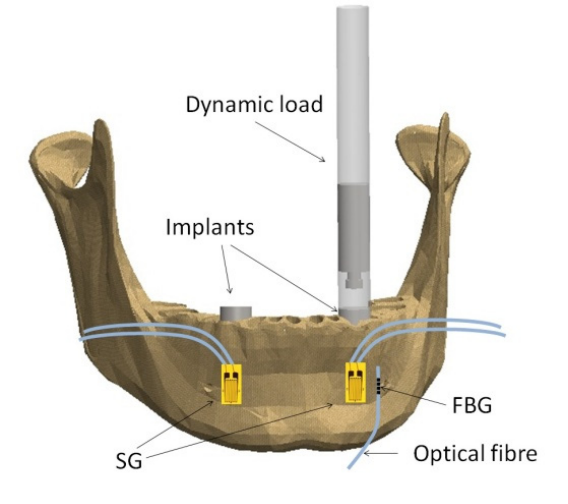
Figure 7. Schematic representation of an implanted cadaveric mandible with fiber Bragg grating and strain gages [122].